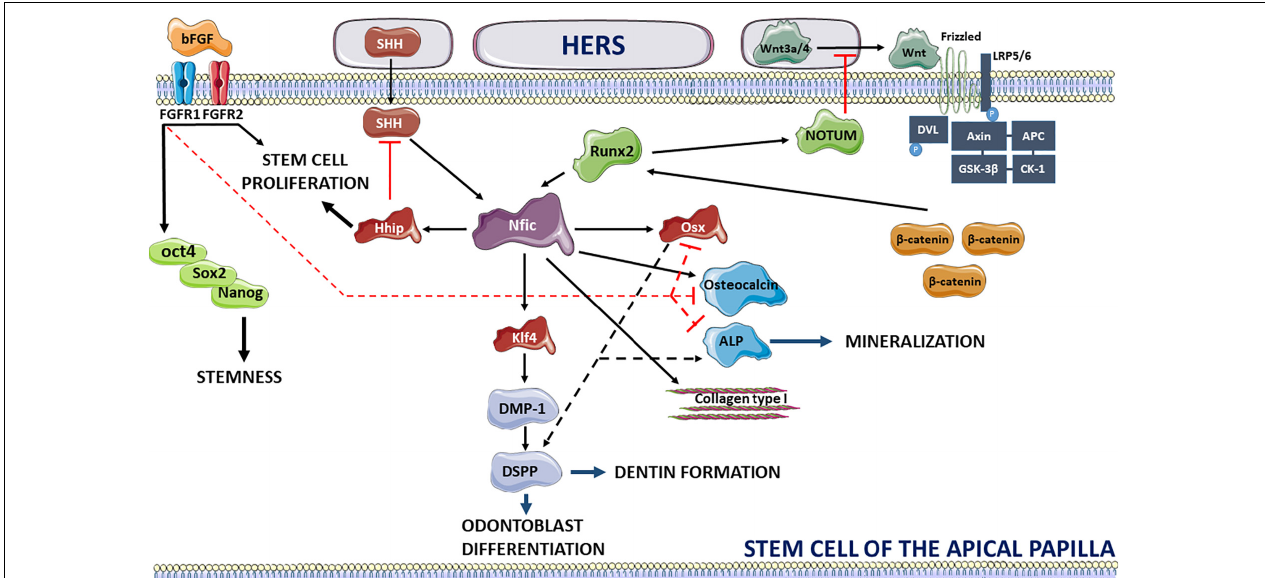
FIGURE 2 | Overview of signaling pathways regulating the stemness of SCAP and promoting dental root development via extrinsic signals of HERS. bFGF maintains the stemness of SCAP via activation of FGFR1 and 2 promoting expression of stemness factors oct4, Sox2, and Nanog, inhibits mineralization through interaction with Osx, Osteocalcin, and ALP and promotes cell proliferation. HERS stimulates dental root maturation by secretion of Wnt3a and Wnt4 interacting with the Frizzled and LRP5/6 receptors. Activation of Wnt signaling acts via binding and phosphorylation of DVL, phosphorylation of LRP5/6 and de-activation of the Axin, APC, GSK-3 β , and CK-1 complex leading to inhibition of β -catenin degradation. Consequently, β -catenin interacts with Runx2 activating the Nfic pathway. Nfic triggers odontoblast differentiation and dentin formation by acting with Klf4 and promoting DMP-1 and DSPP expression. Secondly, Nfic induces mineralization by upregulating Osteocalcin, ALP and collagen type I and through interaction with Osx which promotes ALP production and DSPP expression. Alternatively, HERS activates Nfic signaling independent of Runx2 via secretion of SHH. Wnt and hedgehog signaling pathways are, respectively, antagonized by Runx2-driven secretion of NOTUM and Nfic-promoted expression of Hhip which promotes stem cell proliferation. Activators of signaling pathways are shown in black lines (full and dotted) whereas inhibition is depicted in red. This image was created using Servier Medical Art, licensed under a Creative Common Attribution 3.0 Generic License, available online at